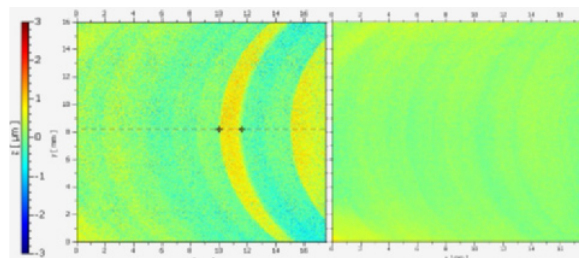
Fig. 2. Sample topographies (area 17,5 x 16 mm²) grinded with temperature compensation on (left) and off (right) Furthermore, correlations between the in-process- measurements and the resulting sample surface topography were already successfully demonstrated for the first time, as can be seen in Fig. 3. The signal of vibrometry, force measurements and topography have been superimposed in the diagram. The positions of topography steps (blue) and vibrometer distance variation (green) are rather well correlated. The force signal (orange) also shows short peaks on the same positions, which represent the moments the temperature compensation triggers a z-axis regulation.